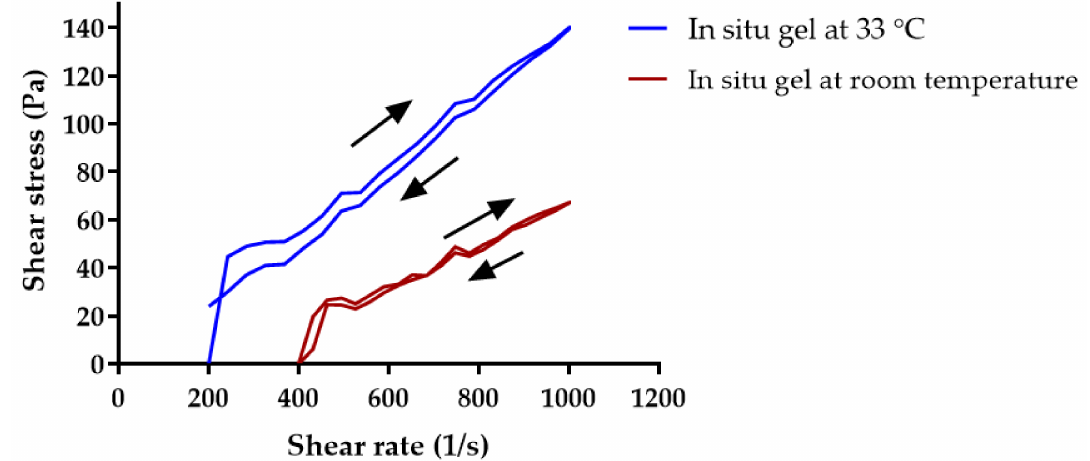
Figure 10. Rheology of the in situ gel loaded with quercetin-loaded PLGA NPs and EGCG at 33 ◦ C and room